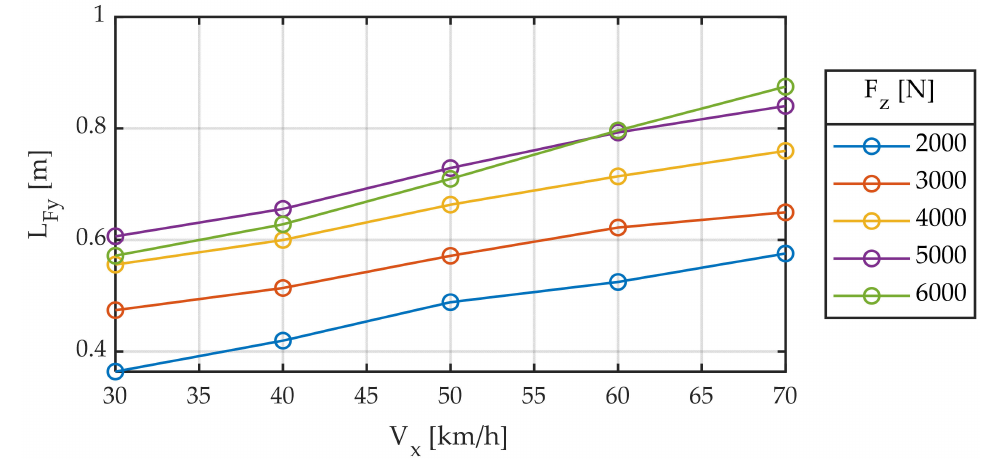
Figure 5. Relaxation length for different vertical loads. Slip angle sweep ± 2 ◦ . Frequency 1.0